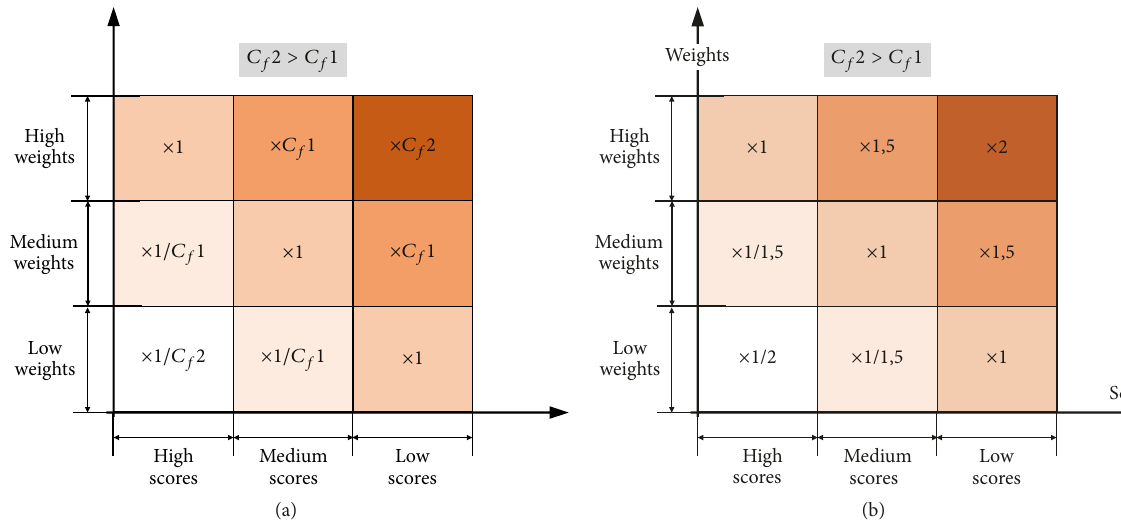
Figure 6: Coefficient matrix affecting the heritage value in CR5